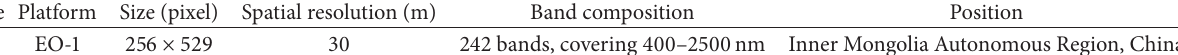
Table 1: Parameters of the original test images.